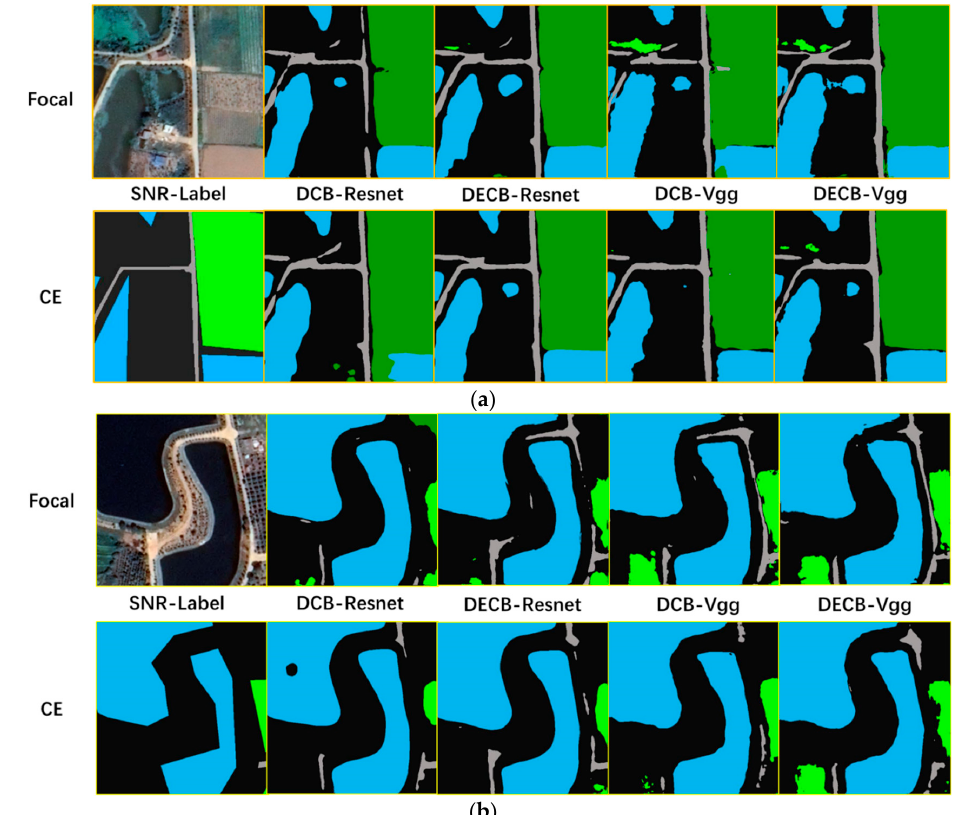
Figure 10. Example of segmentation results for the LoveDA-r-road dataset: ( a ) Sample of correct triple classification markers and their segmentation results. ( b ) Sample of incorrect triple classification markers and their segmentation results.